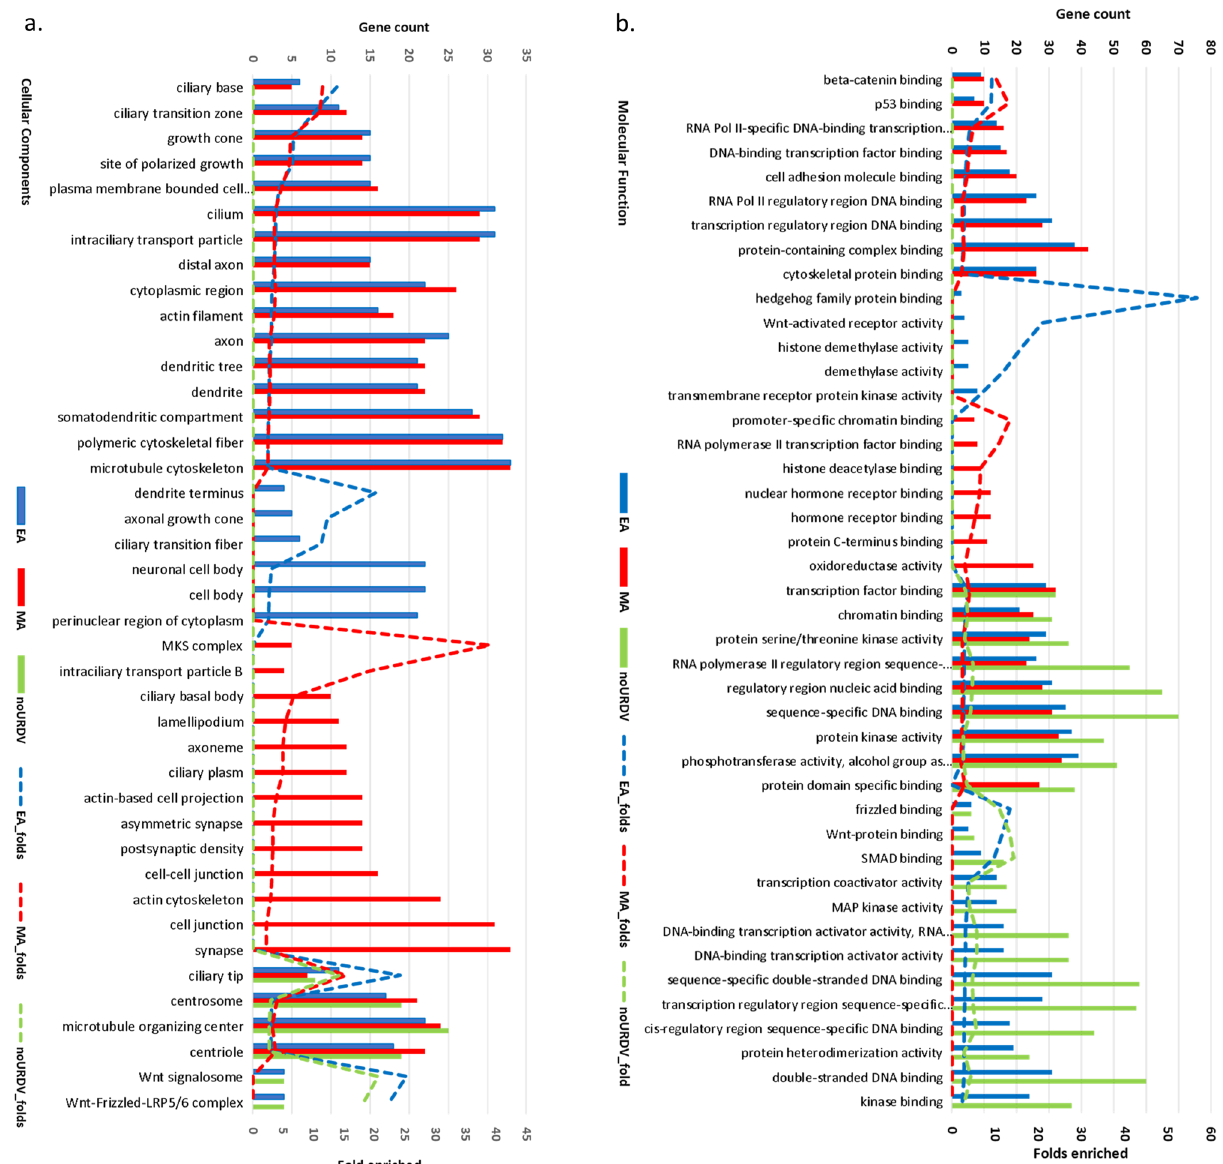
Figure 4. Results of ontology and pathway enrichment analysis of candidate genes with and without URDVs identified. Enrichment analysis of ( a ) cellular components, ( b ) molecular functions, ( c ) pathways, and ( d ) biological processes, were performed using online tools ToppFun and ToppCluster. Count of URDV-containing genes in ontology class for EA (blue) and MA (red) MMC subjects and genes without URDVs (green) were shown with bar charts. Enrichment folds were represented with dashed lines for URDV-containing genes in EA (blue), URDV-containing genes in MA (red) and genes without URDVs (green). Enrichment comparisons passed Bonferroni correction. Detail descriptions of ontology, gene names, fold enrichment, and Bonferroni corrected P values can be found in Supplementary Table